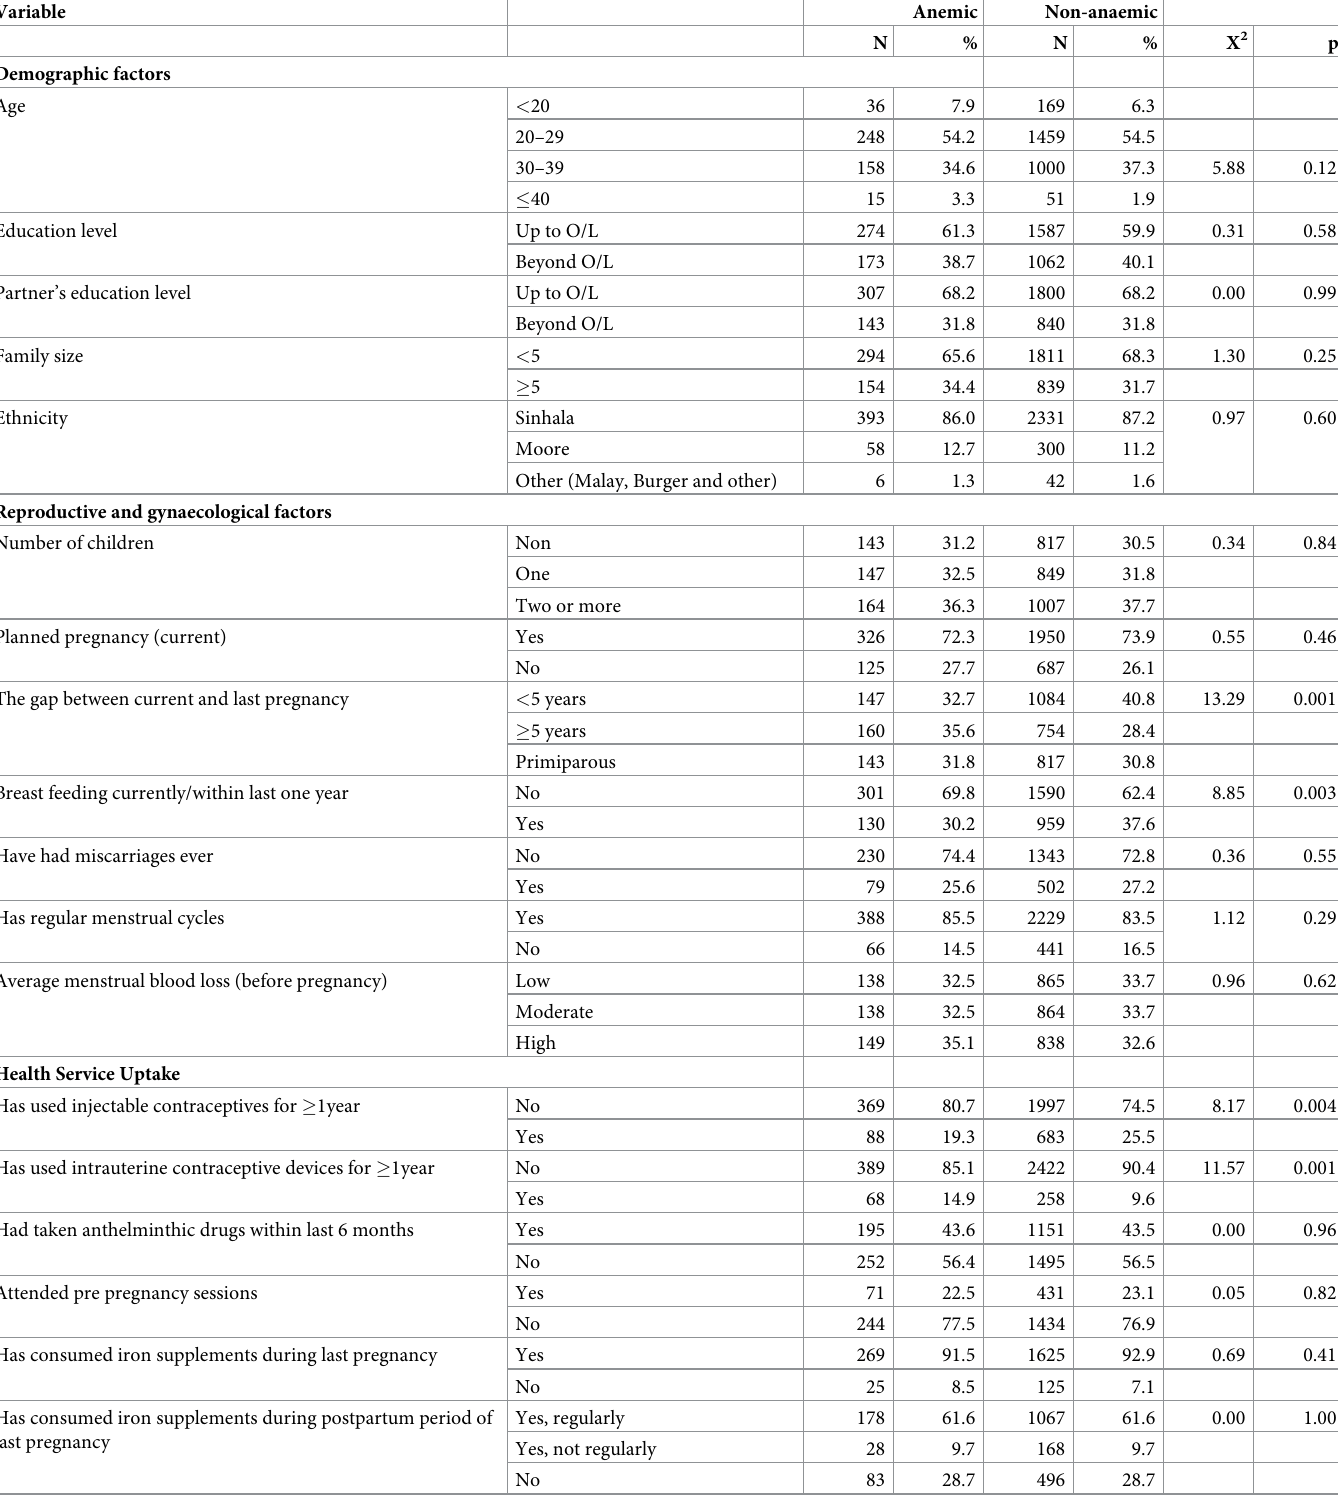
Table 1. Demographic and health factors associated with anemia among first-trimester pregnant women in the Anuradhapura district.